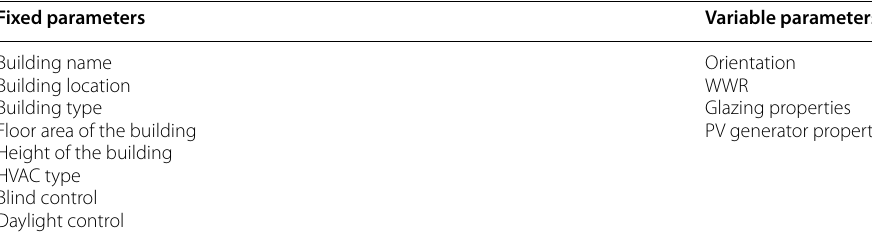
Table 3 Fixed and variable parameters Fixed